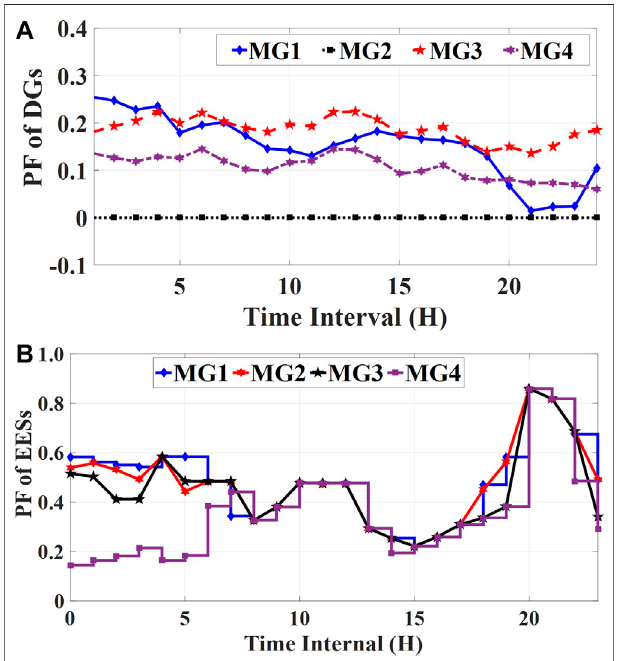
FIGURE 8 | Participation factor of (A) DGs and (B) ESSs.